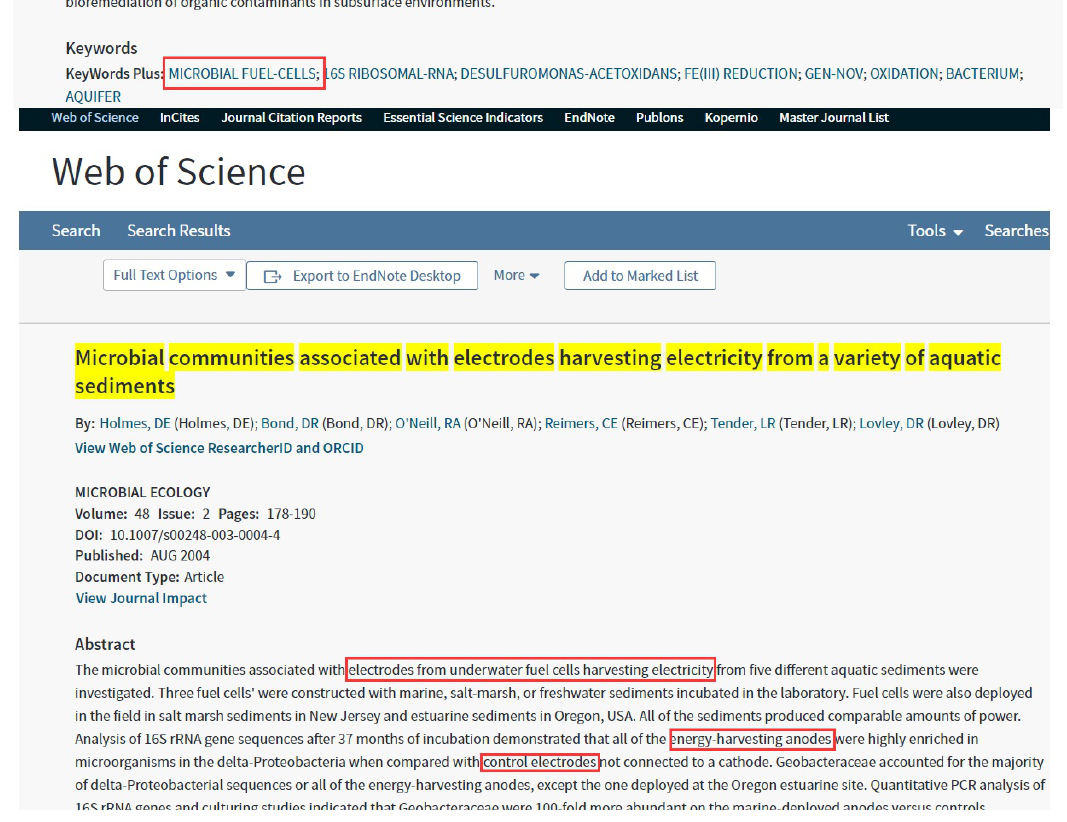
Figure 1. Words that proved the papers are closely related to our study subject.